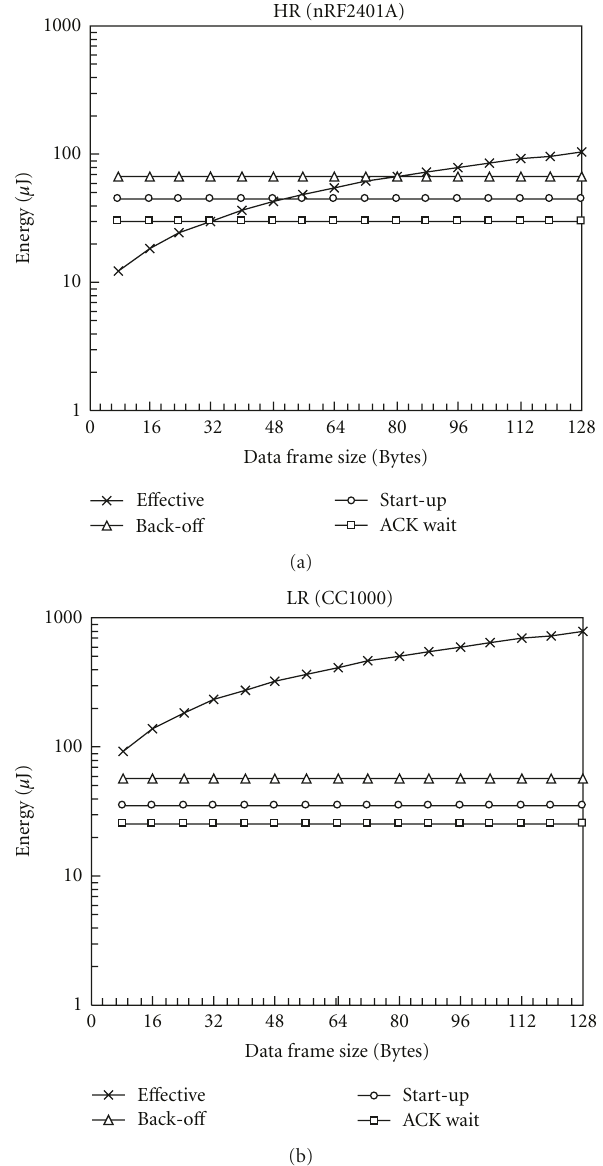
Figure 1: The e ff ective and overhead energies of nRF2401A (HR) and CC1000 (LR) platforms.